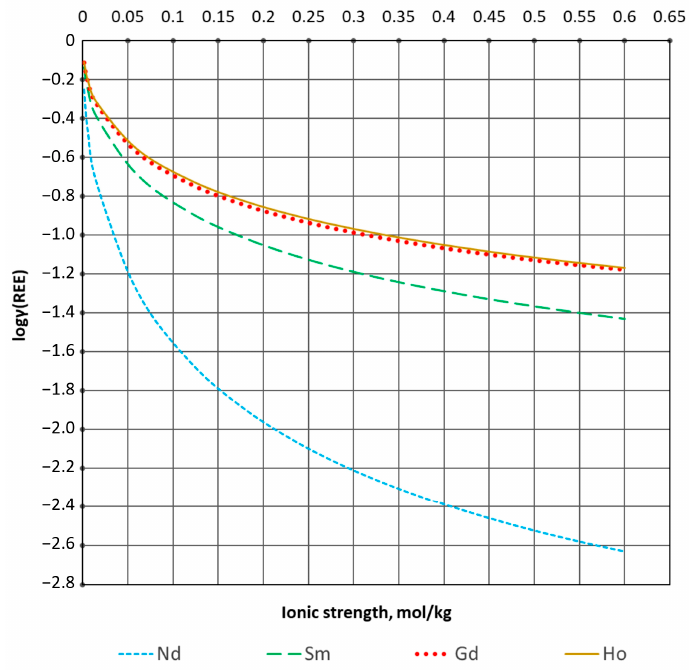
Figure 3. REE activity coefficients in carbonate–alkaline solution.